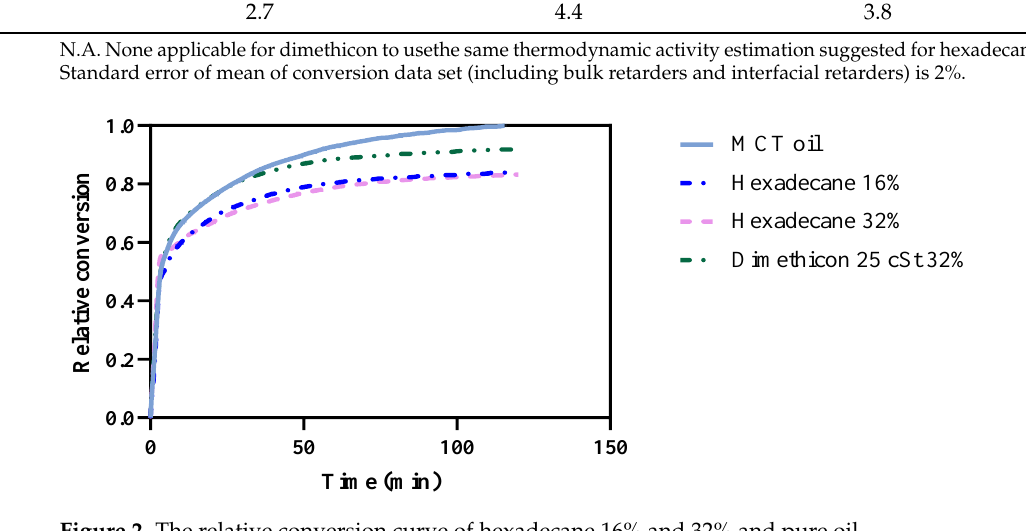
Figure 2. The relative conversion curve of hexadecane 16% and 32% and pure